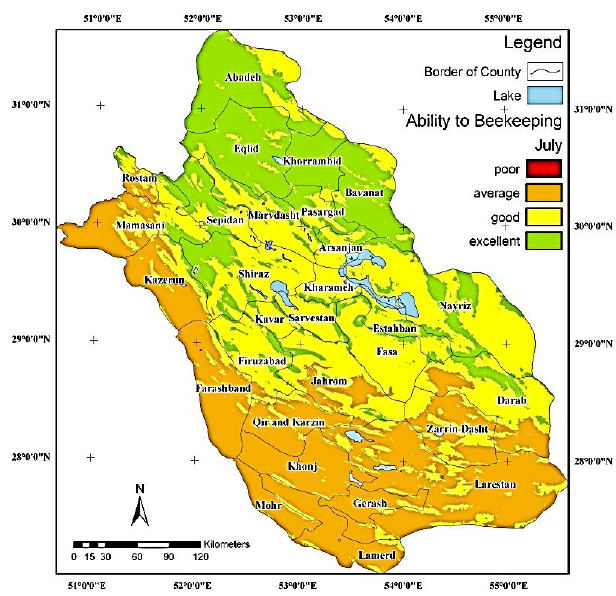
Fig. 4. Suitability of climate conditions for beekeeping in